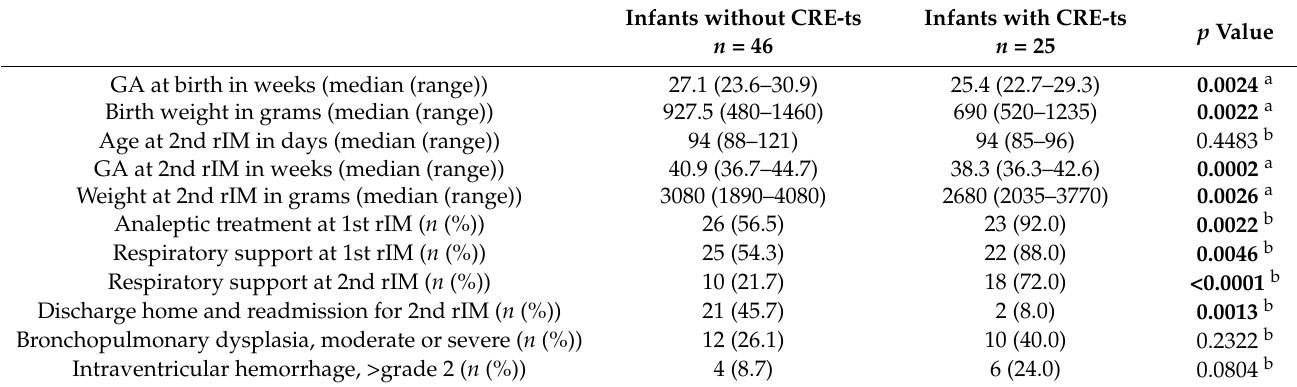
Table 4. Clinical data of infants with and without CRE-ts after the second immunization. Infants without CRE-ts